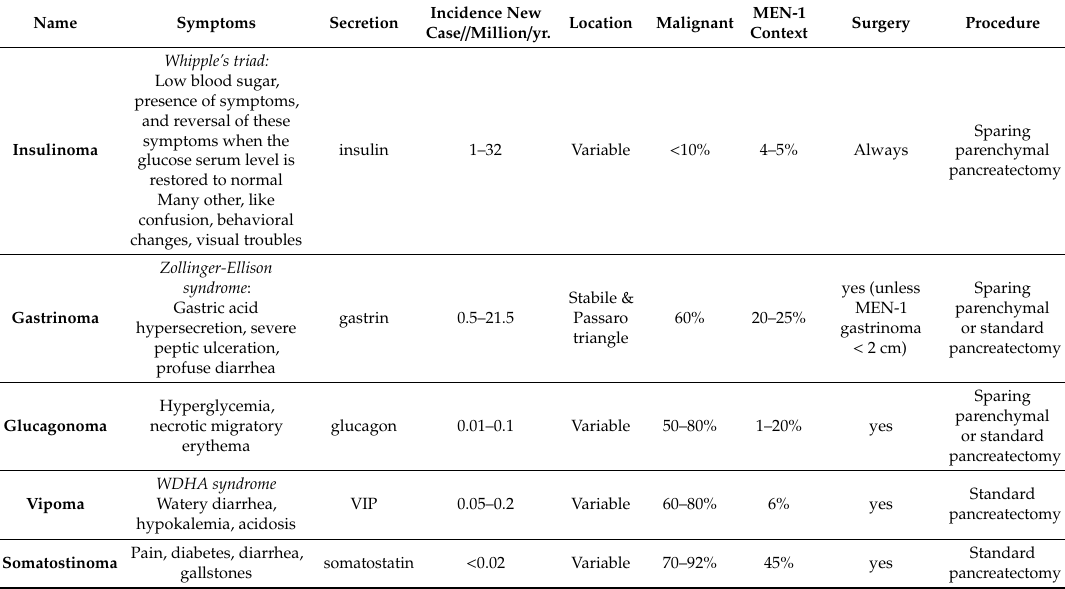
Table 1. Symptoms, characteristics and surgical approach in relation with the most frequent functional